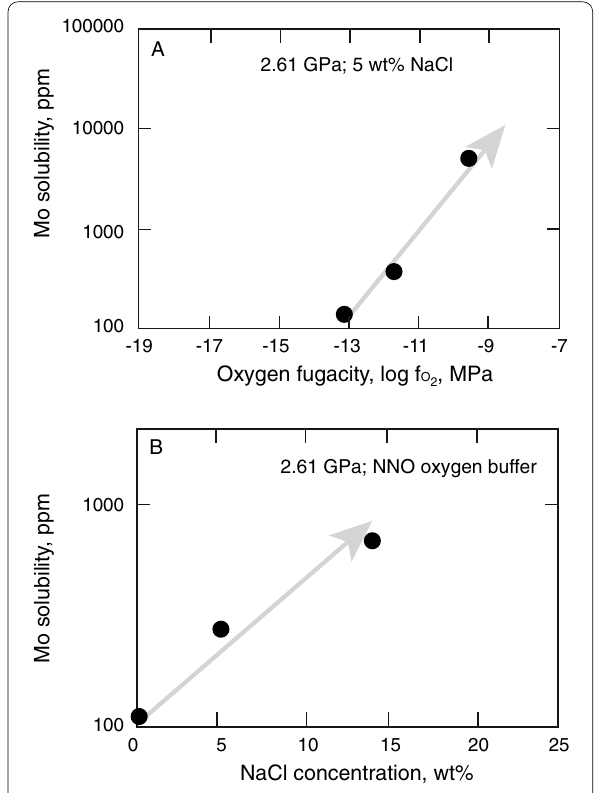
Fig. 26 Molybdenum solubility in H 2 O–NaCl solutions. A . As a function of oxygen fugacity in 5 wt% NaCl saline solution at 2.61 GPa and 700 °C. B . As a function of NaCl concentration at 2.61 GPa and 700 °C at the oxygen fugacity of the NNO buffer. Modified after